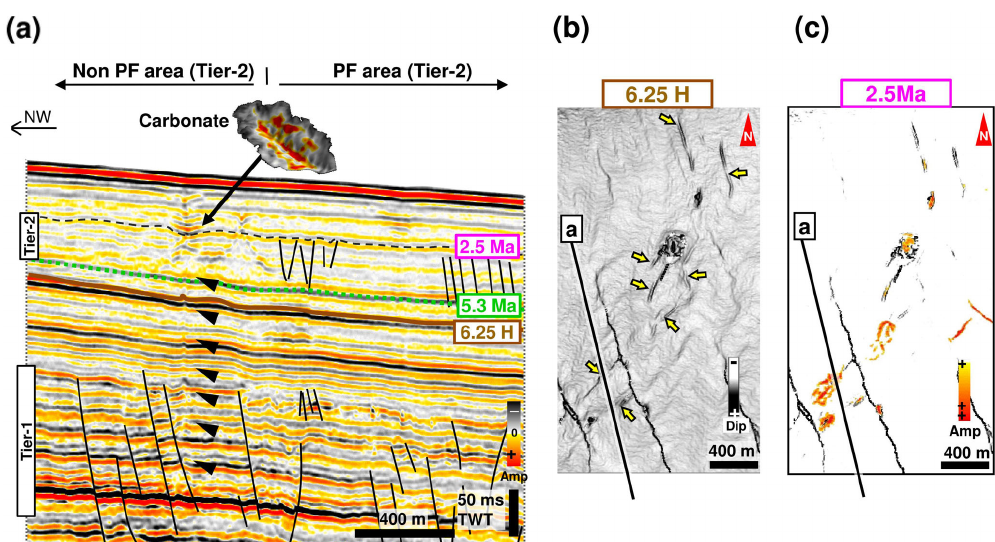
Figure 6. Group of Linear Chimneys with flame-liked PHAAs at upward terminations. (a) Seismic section shows the Linear Chimneys emanating from Tier-1 and terminating upward in the upper Pliocene units. This section is a close-up of the thinning wedge studied in Ho et al. (2013). The full profile is shown in Fig. 3. Line location is shown in (b) and (c) . (b) Dip map of horizon 6.25H showing the linear planform of chimneys (yellow arrows). (c) Isolated, positive, high-amplitude anomalies at the top boundary of Tier-2. They occur at the topmost termination of Linear Chimneys and are interpreted as methane-related carbonates.